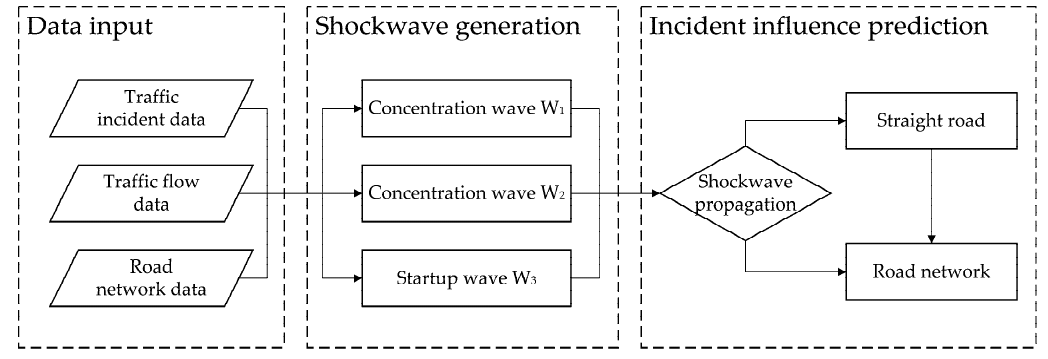
Figure 1. Schematic illustration of the spatiotemporal influence prediction model for a traffic incident. After an incident occurs, a shockwave is generated and propagates along the road. Two other